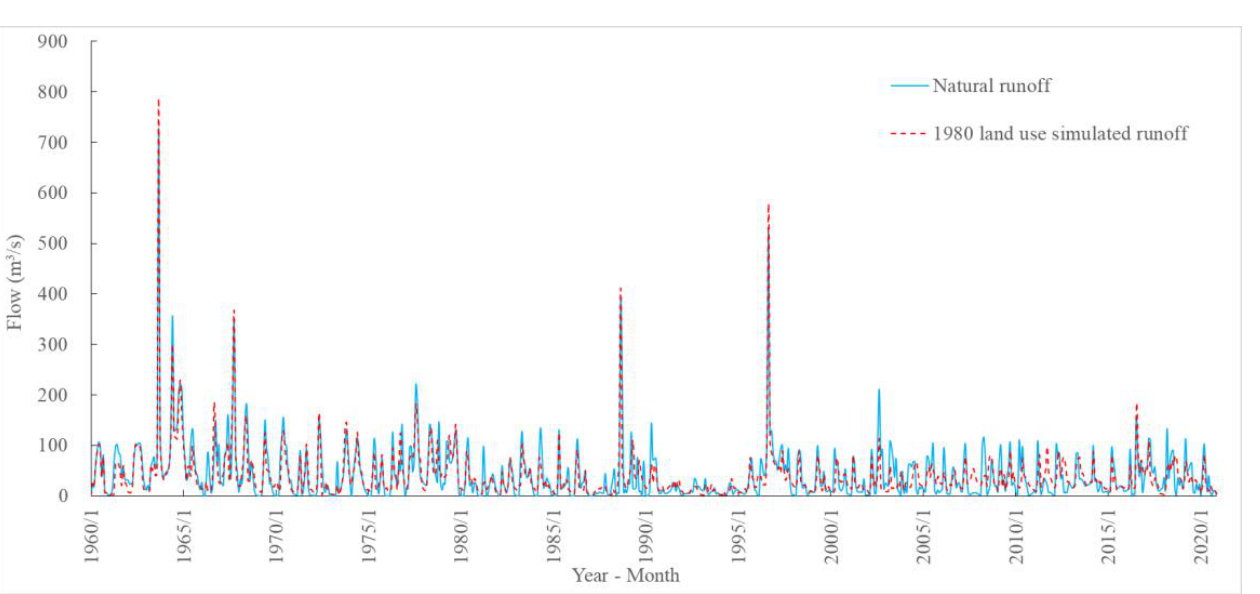
Table 8. Comparative analysis of simulated and natural values of annual runoff under different land-use scenarios.